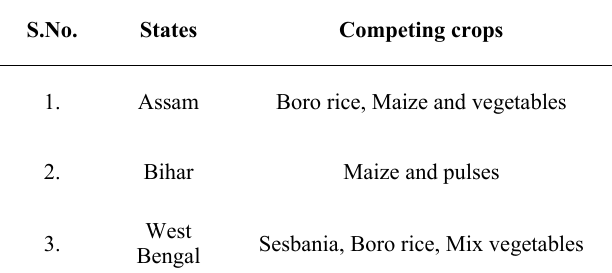
Table 1: Competing crop in the jute study